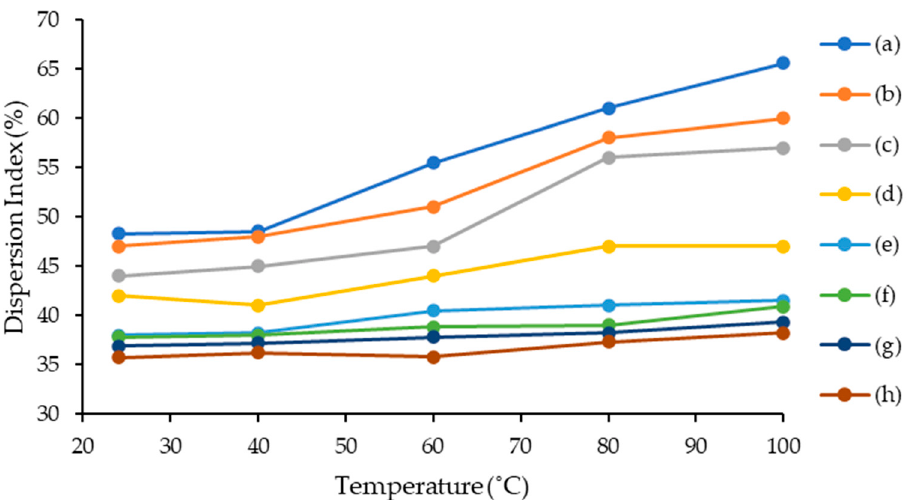
Figure 6. Temperature effect for asphaltene dispersion study. (a) [C 16 C 1 Pip] 2 [LS], (b) [C 12 C 1 Pip] 2 [LS], (c) [C 8 C1Pip] 2 [LS], (d) [C 6 C 1 Pip] 2 [LS] (e) [C 16 C 1 Pip][Cl], (f) [C 12 C 1 Pip][Cl], (g) [C 8 C 1 Pip][Cl], (h) [C 6 C 1 Pip][Cl].